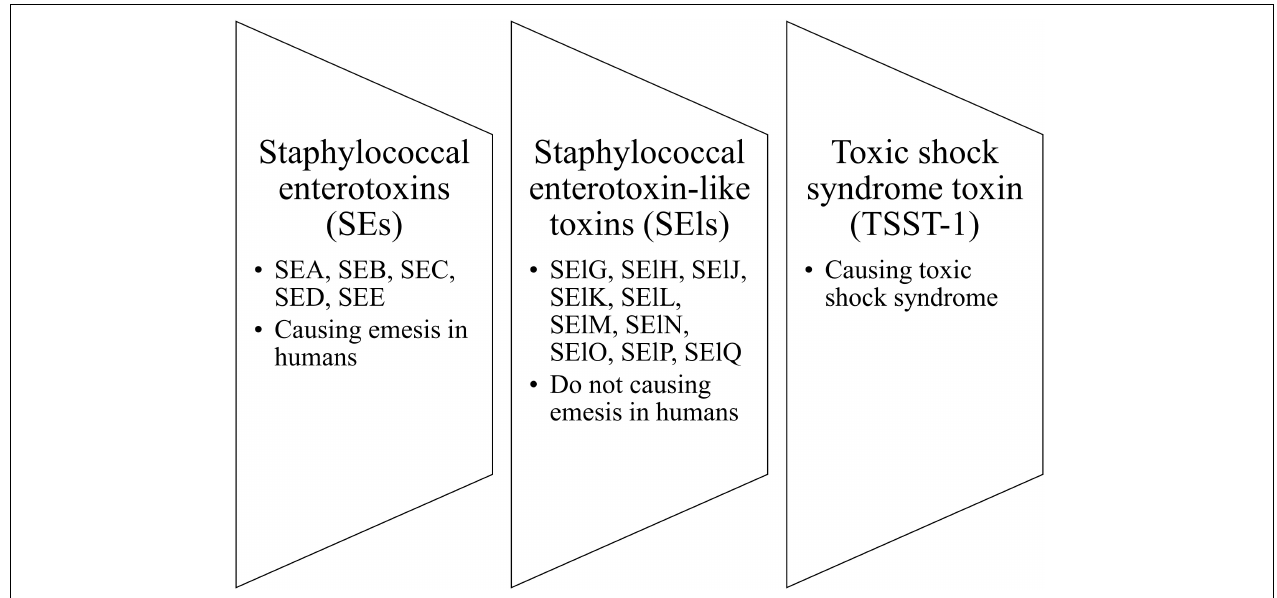
FIGURE 4 | Three clusters of staphylococcal